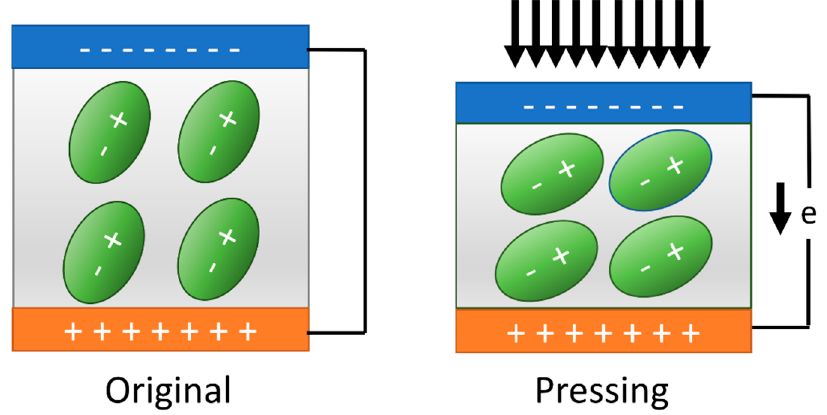
Figure 7. Physical principle of piezoelectric generator [9].